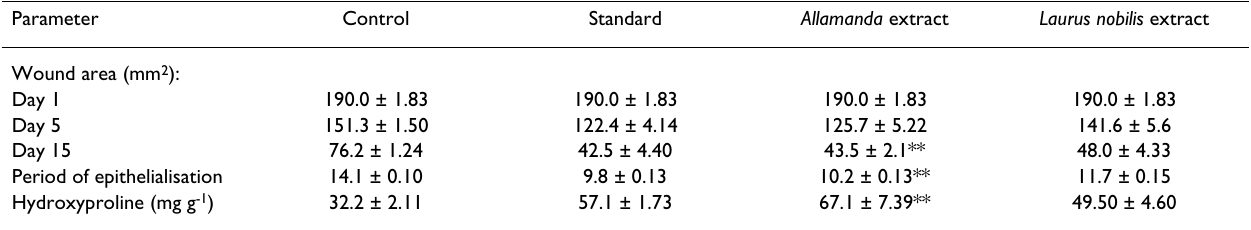
Table 1: Effects of topical application of Allamanda cathartica and Laurus nobilis in excision wound model Parameter